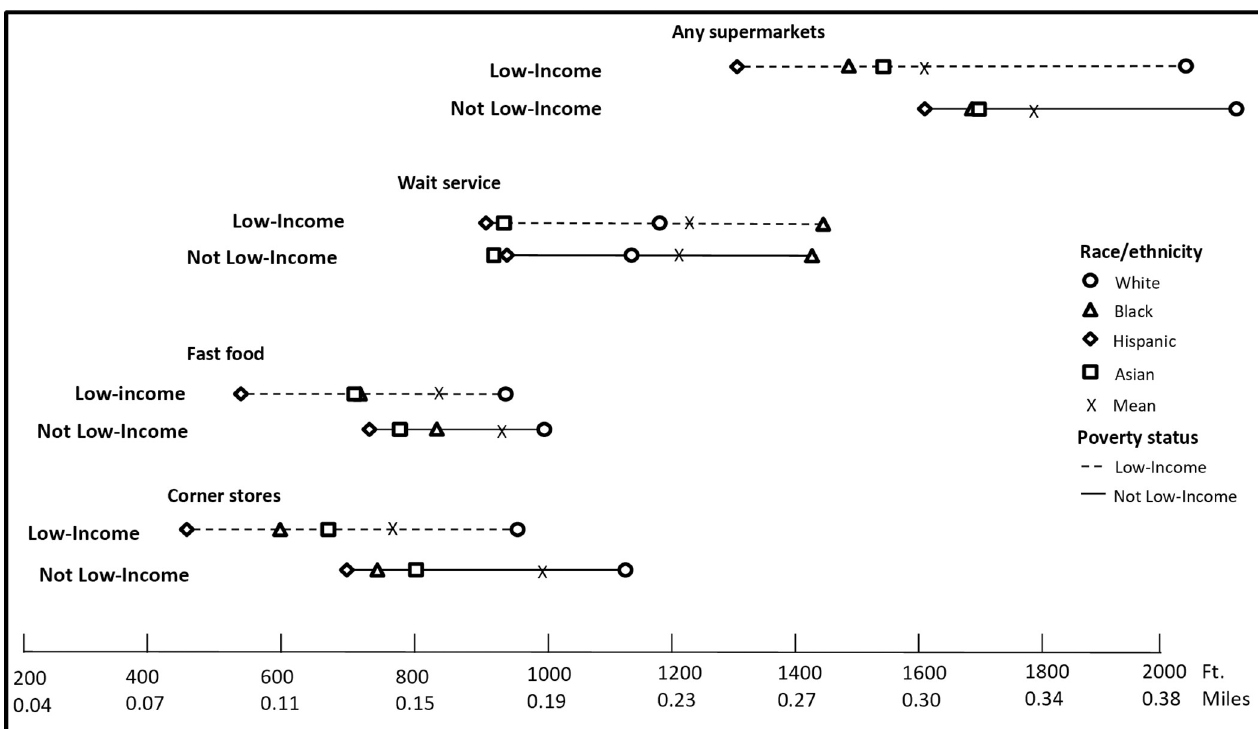
Fig 2. Mean nearest distance in feet to food facilities from home by race and poverty interactions in 2013. We conducted a joint F-test, which suggests significant differences among income and race groups (p < 0.05), and pair-wise T-tests for multiple comparisons based on Bonferroni correction (28 pairs in total, with each pair tested on all four food outlets, separately). The majority of comparisons were statistically significant (p < 0.05). S18 Table presents test results (p-values) for each pair.